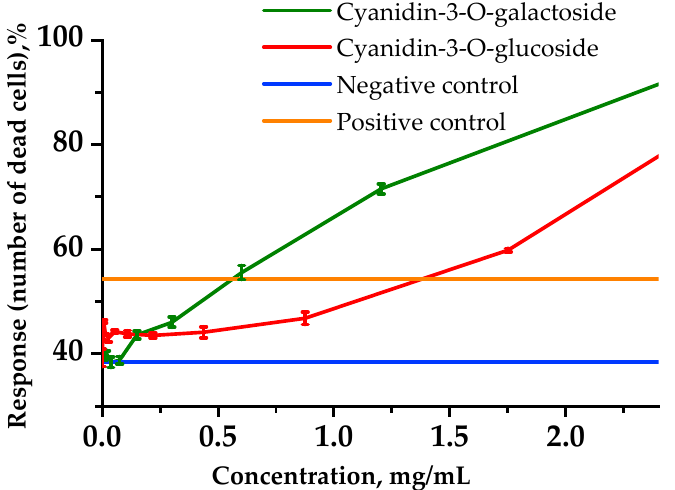
phoblast RPMI-1788 cell line (Figure 3). Cyclophosphamide (CP) as a cytostatic drug inhibited cell vitality. For example, in a positive control medium with CP at 1.25 mg/mL, the number of dead cells increased to 54.3%.